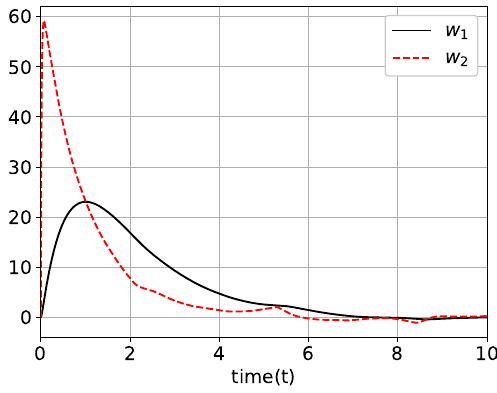
Figure 11. The proposed HOSD: trajectories of w 1 and w 2